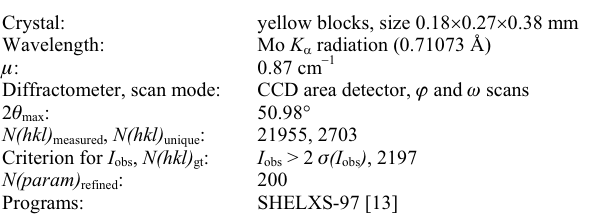
Table 1. Data collection and